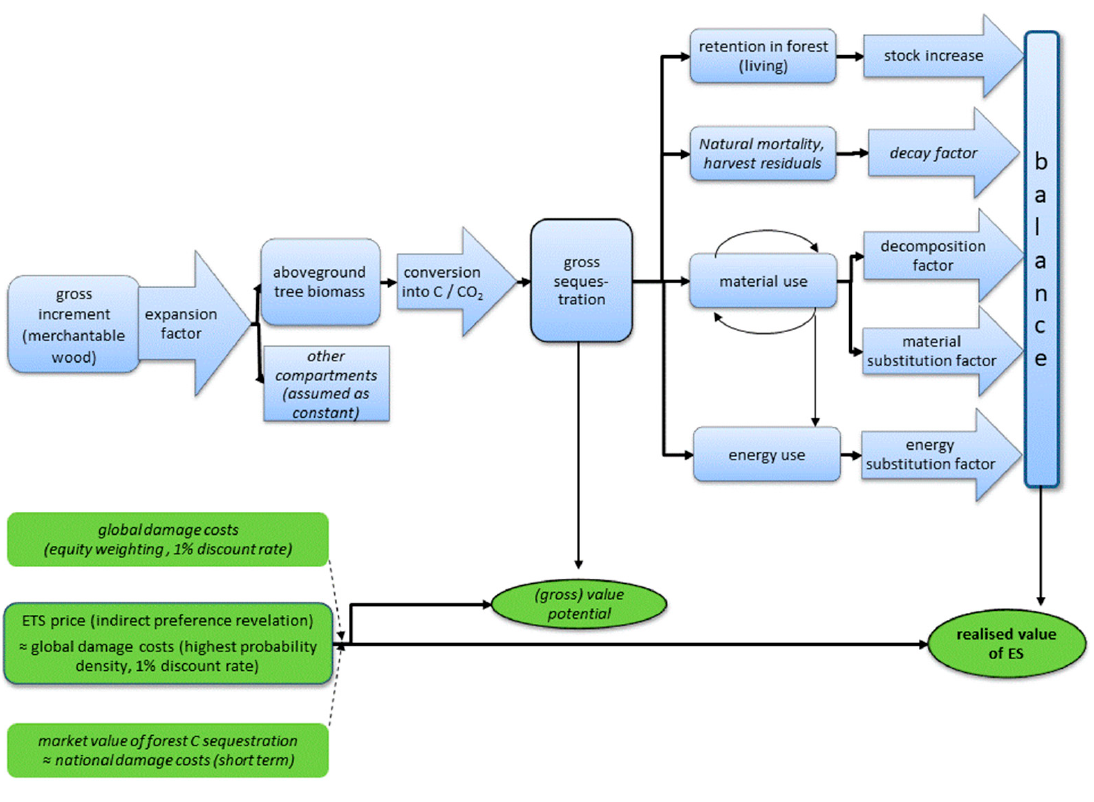
Figure 2. Procedure for quantifying and valuing carbon sequestration ( italics: not applied here).